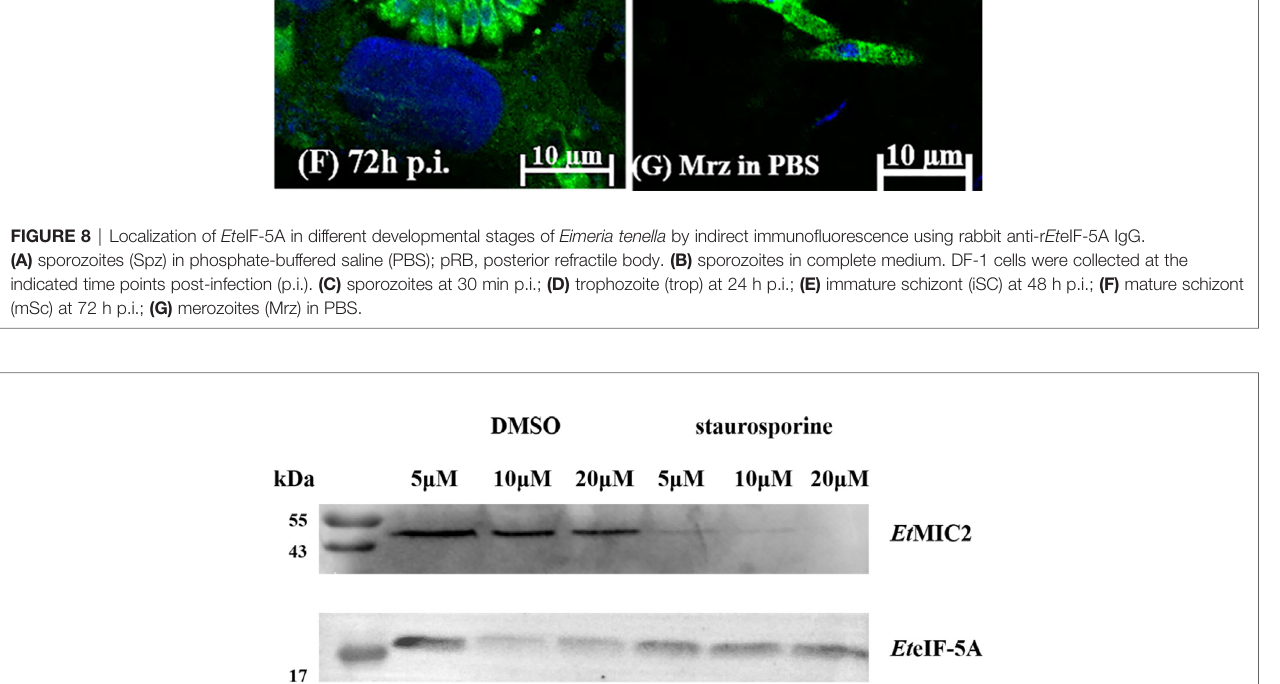
Frontiers in Cellular and Infection Microbiology |